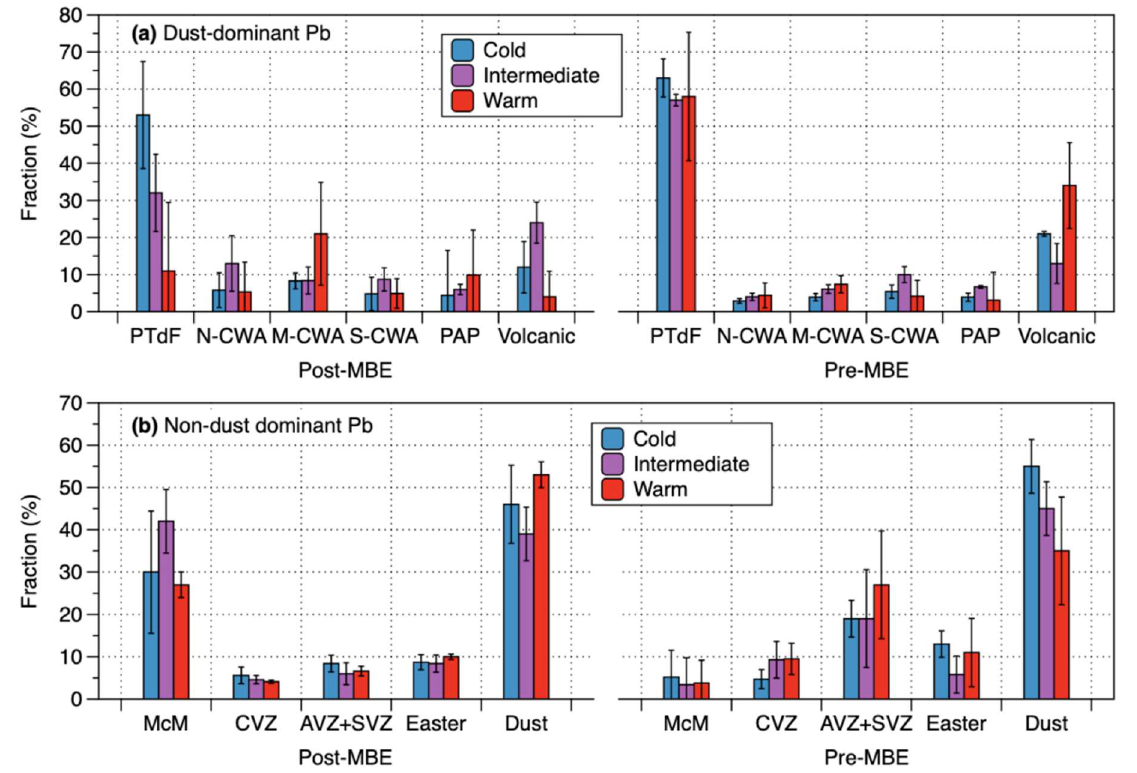
Figure 3. The relative contributions (in %) of ( a ) the potential dust sources for dust-dominant samples and ( b ) the potential volcanic sources for non-dust dominant samples calculated using an isotope mixing model (see Methods and Tables S3 and S4). The acronyms are defined in Figures S2 and S3. The bar graph shows the median values and vertical lines represent standard deviations of a data set.